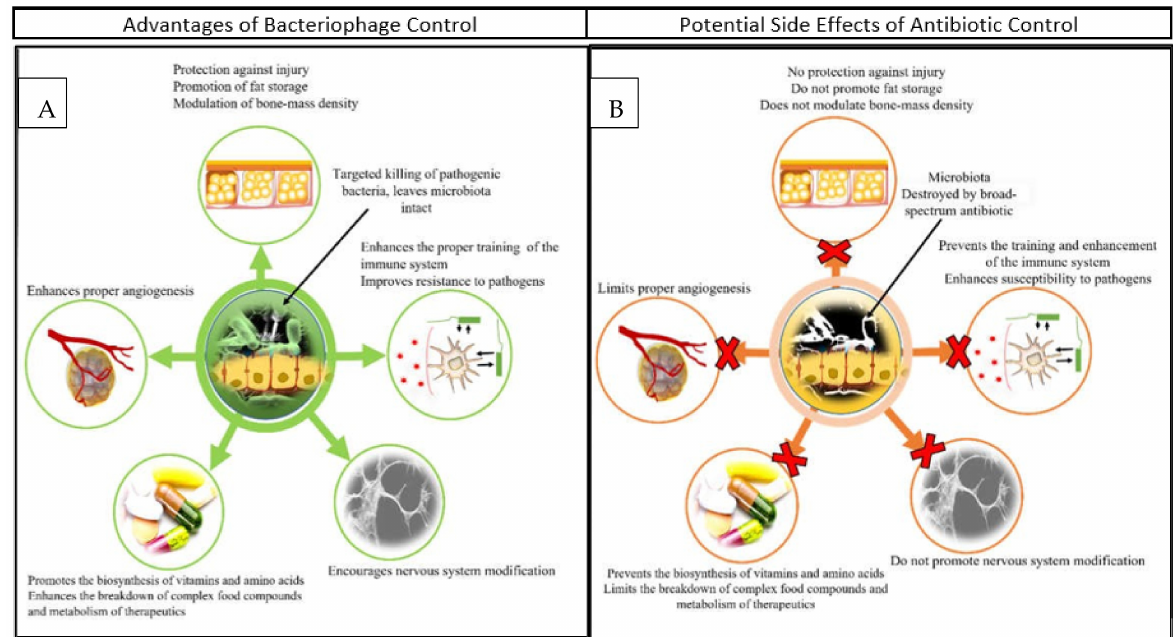
Figure 2. Comparison of bacteriophage ( A ) and antibiotic ( B ) application and their respective impact on